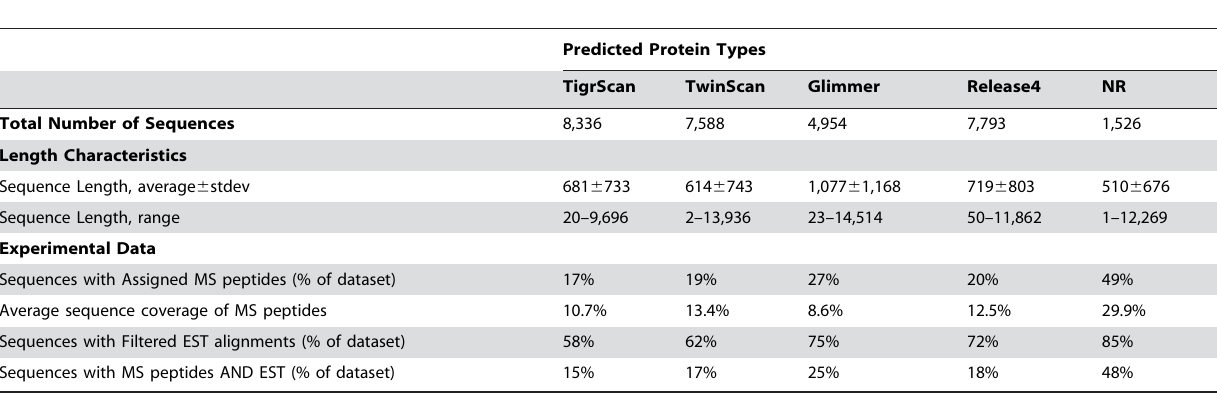
Table 2. Length characteristics (average, standard deviation, and range) and experimental data (MS peptides, MS coverage, EST alignments, MS AND EST data), for sequence of each prediction